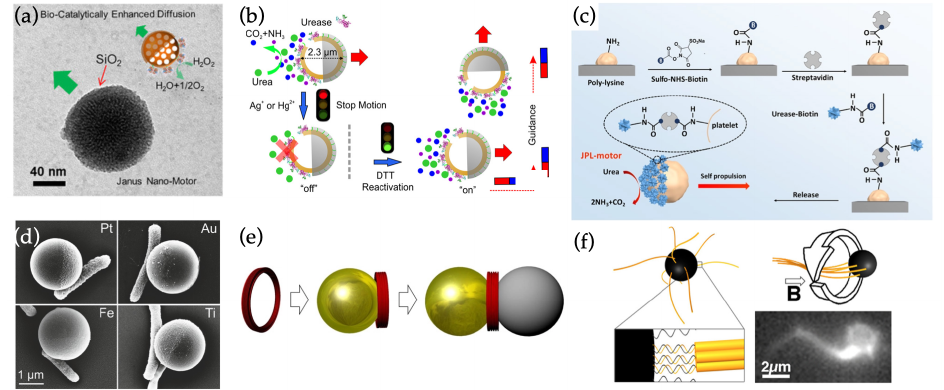
Figure 4. Hybrid nanoswimmers. ( a ) Silica nanosphere partially coated with catalase enables propulsion through enzymatic reactions. ( b ) Hollow mesoporous silica nanosphere partially coated with urease enzymes, which enables urea-fueled propulsion and toggling of movement by chemically inhibiting and reactivating the enzyme. ( c ) Coating a platelet cell with urease allows creation of a cell-based urea-fueled swimmer. ( d ) E. coli attached to capped Janus spheres provide random tumble motion to the particles, but the system can also be magnetically steered if a magnetic metal (Fe) is used for coating. ( e ) DNA origami nanoring that can be used for creating self-thermophoretic Janus- type assemblies. ( f ) Magnetic nanoswimmer with synthetic DNA origami flagella. (cid:126) B denotes